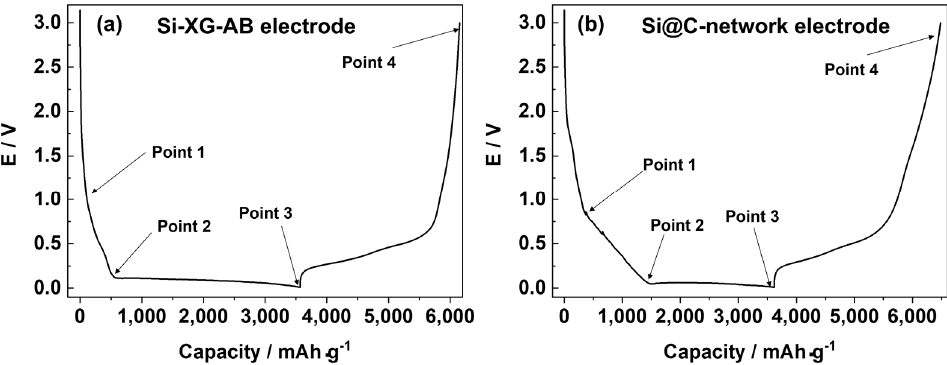
Figure 1. The first cycle of charge–discharge curves of ( a ) Si-XG-AB electrode and ( b ) Si@C-network electrode for XPS and ToF-SIMS sample preparations performed in 1M LiPF 6 /DMC electrolyte at 200 mA · g − 1 .